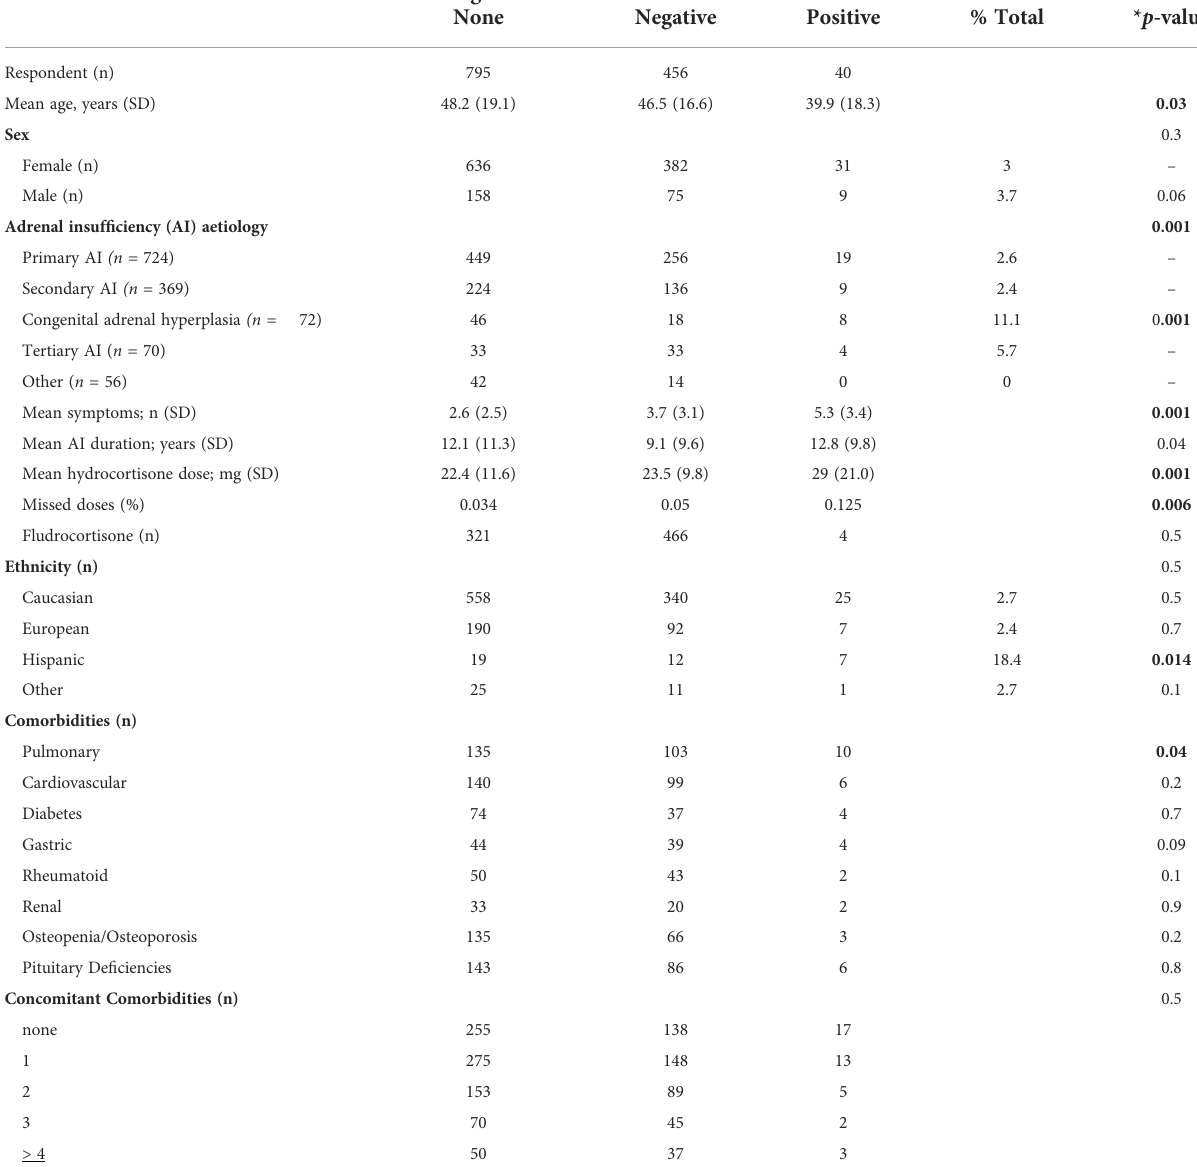
TABLE 2 Respondent Characteristics with Respect to COVID-19 Test Results ( *p -value< 0.05 considered signi fi cant; NS= not signi fi